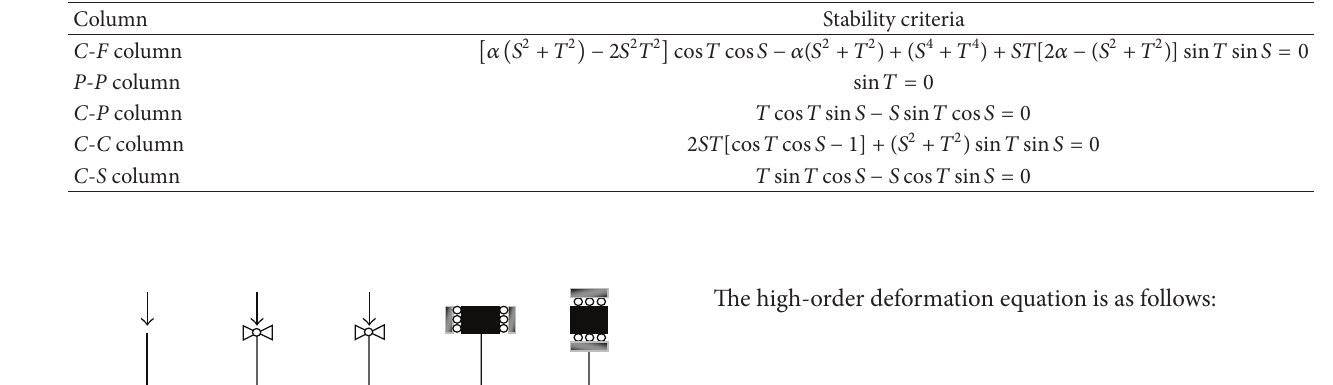
Table 1: The stability criteria for continuously restrained elastic columns.